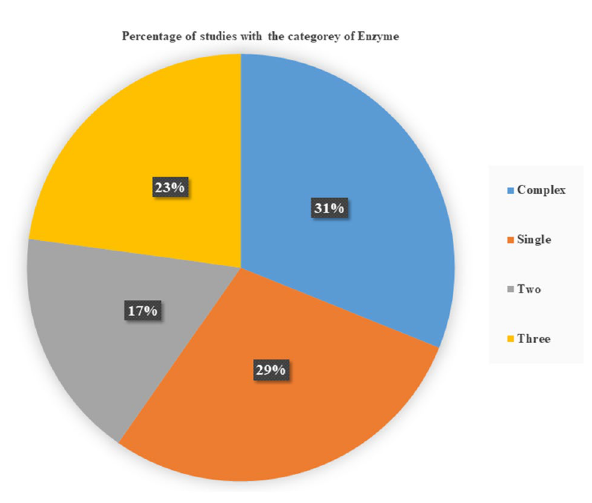
Figure 1. Pie-chart showing the total percentage of the studies by each enzyme supplement